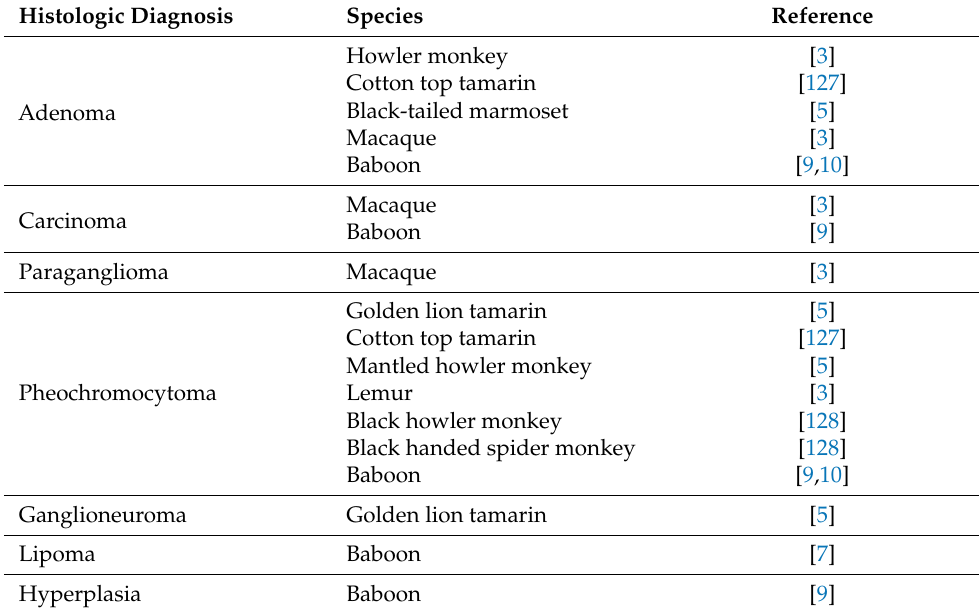
Table 2. Distribution of spontaneous adrenal neoplasms in nonhuman primates, by